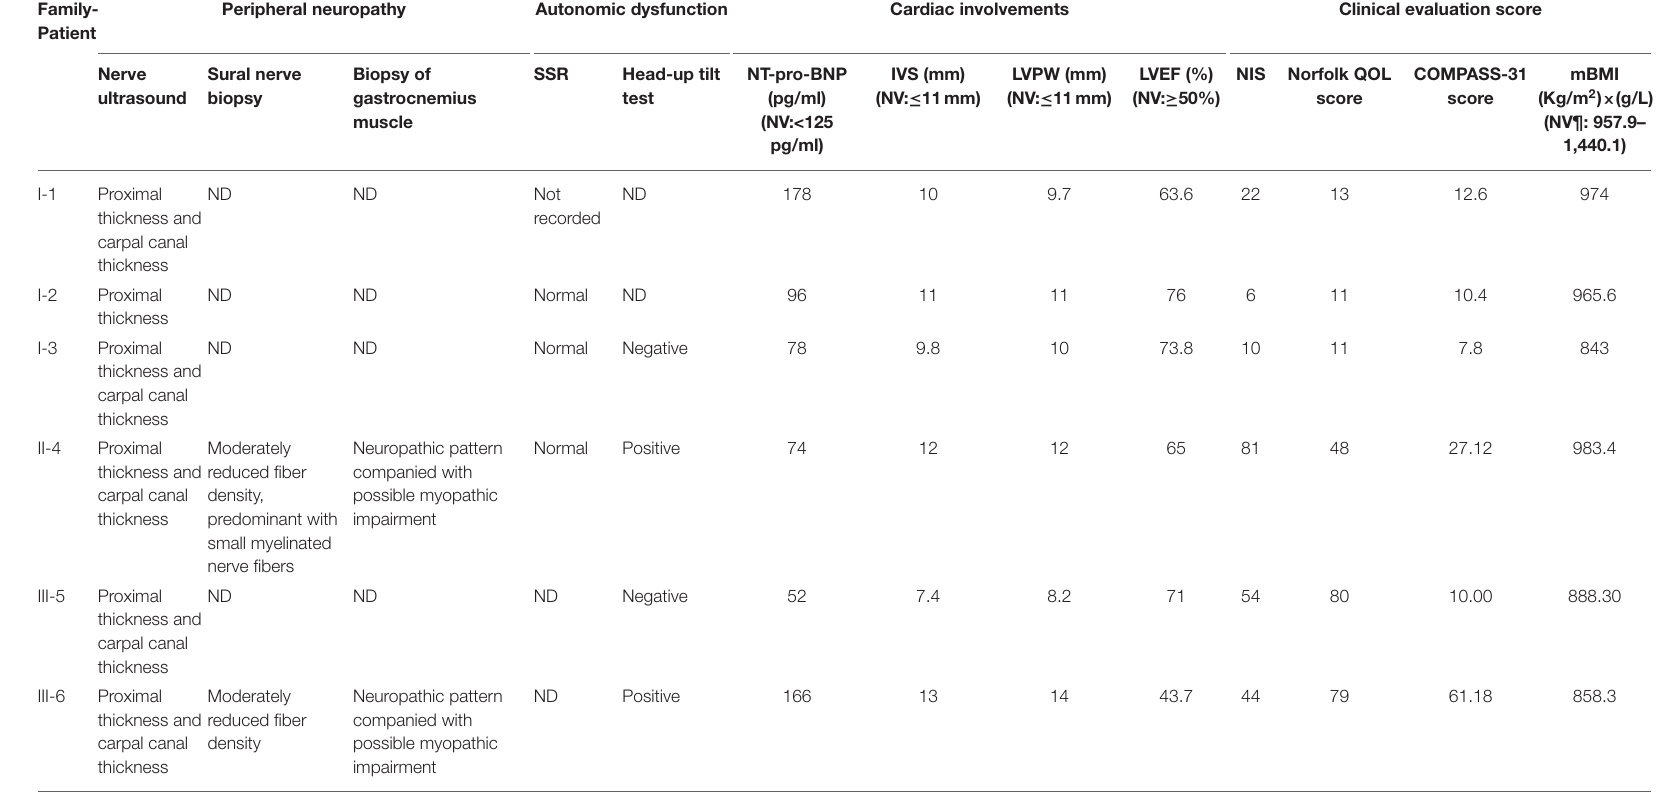
TABLE 2 | Extraocular characteristics of patients with symptomatic ATTR having the Gly83Arg